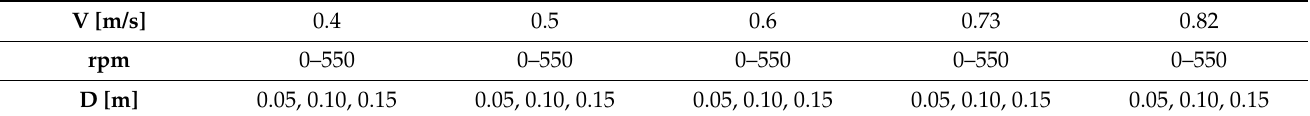
Table 2. Parameters ranges used during experiments.